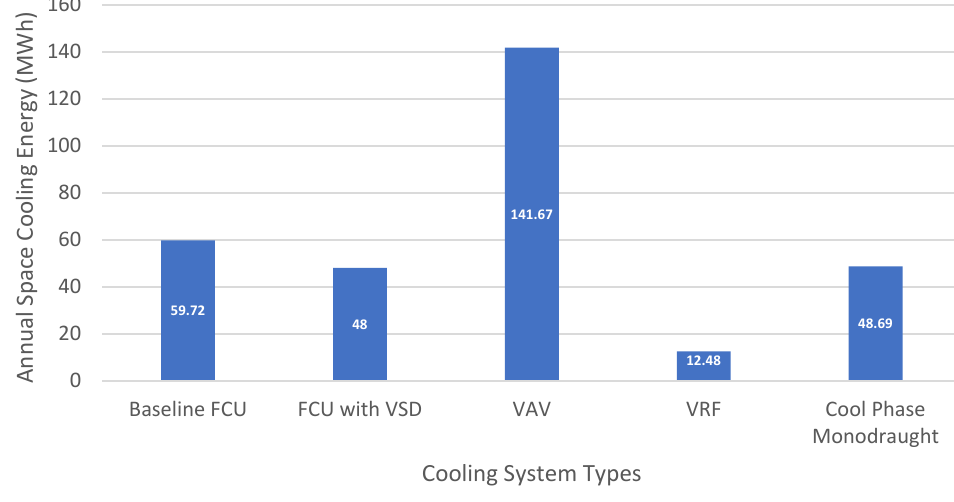
Figure 4. Annual space cooling energy for different cooling systems.